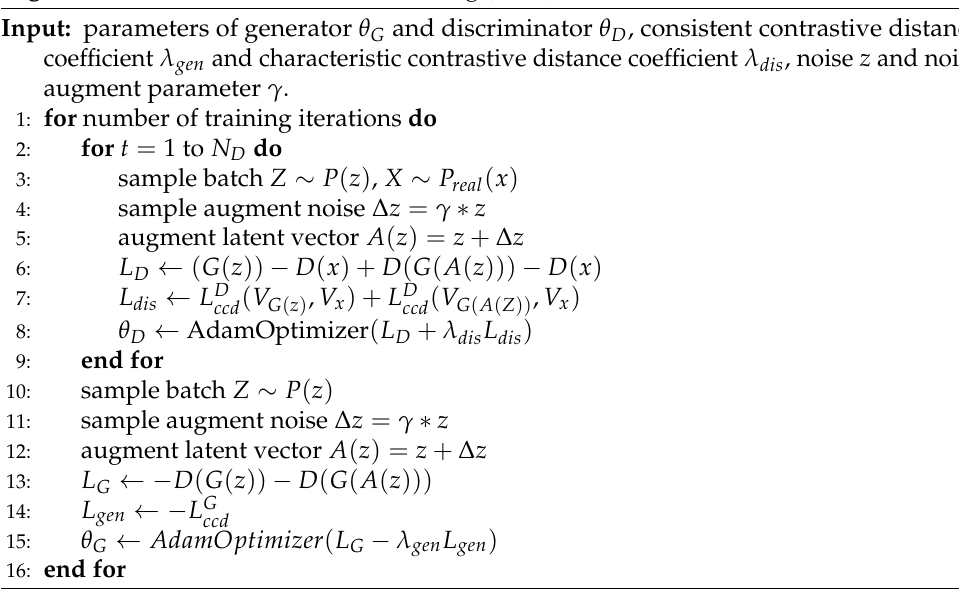
Algorithm 1 Contrastive Distance Learning